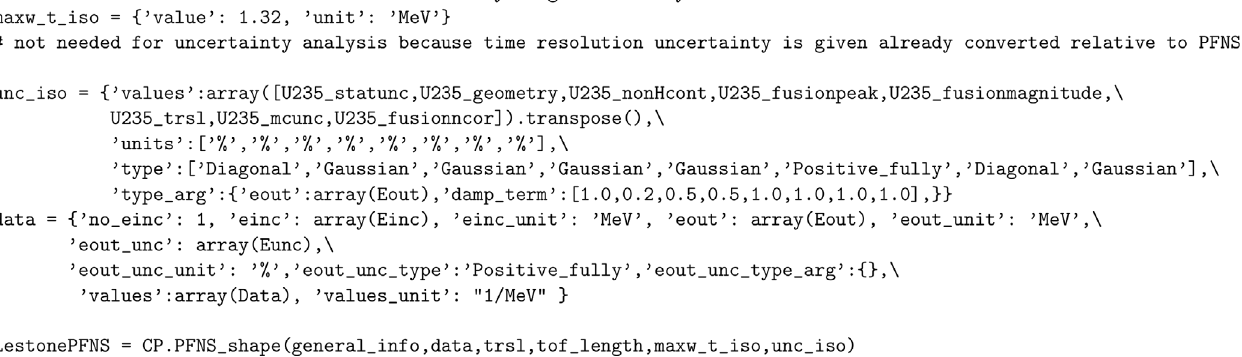
Fig. 2. An ARIADNE input deck for estimating total covariances for Lestone et al. data is